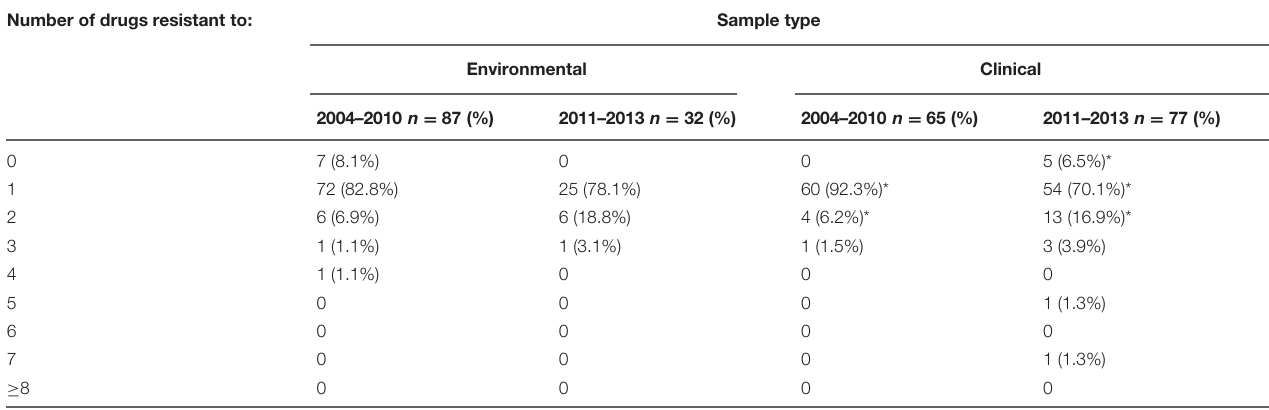
TABLE 3 | Drug resistance and multidrug-resistance among clinical and environmental Vibrio parahaemolyticus strains isolated from 2004–2010 and 2011–2013 periods. Number of drugs resistant